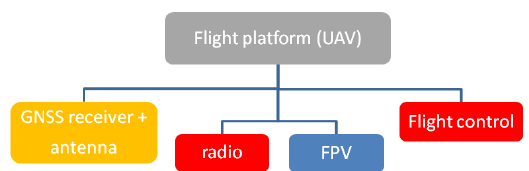
Figure 4. Standard design of a flight platform